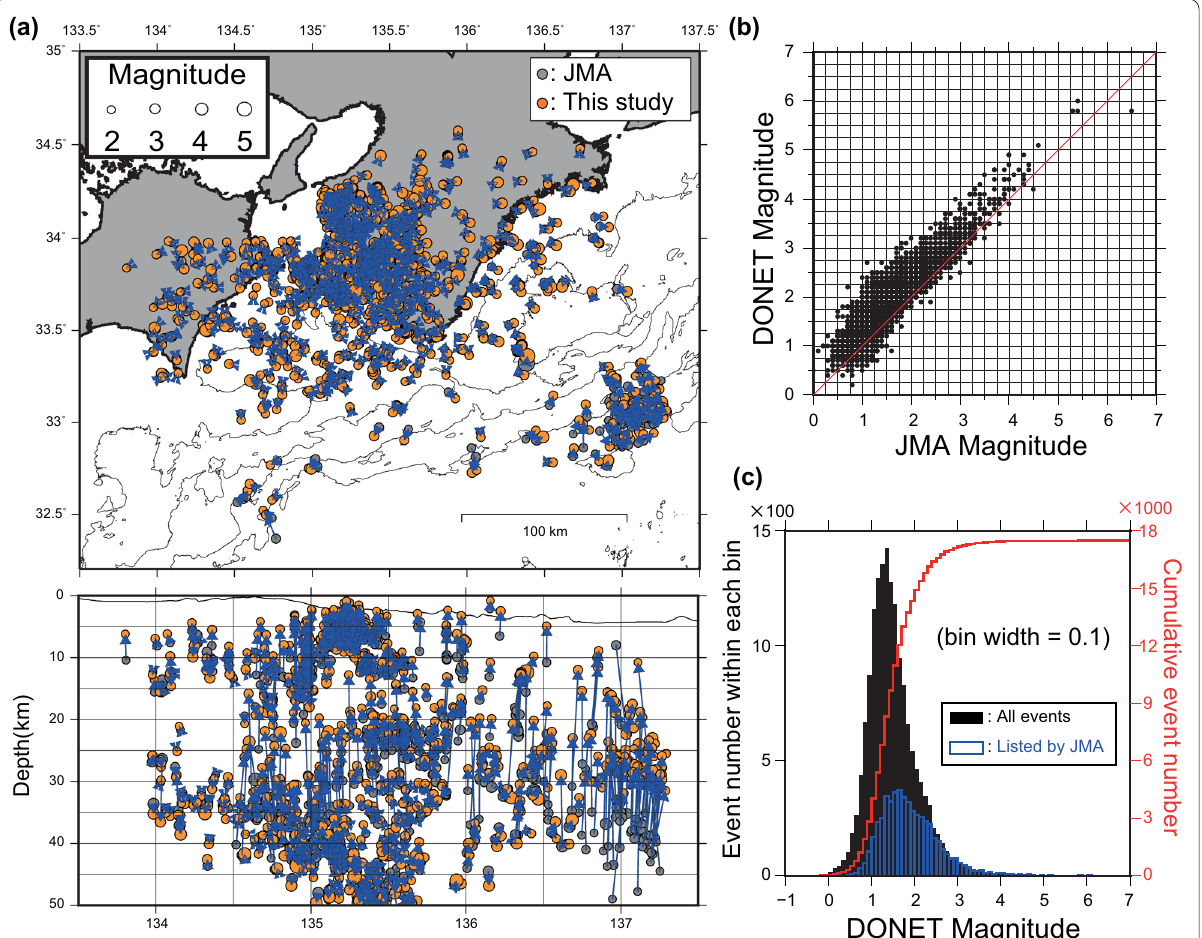
Fig. 6 Comparison of hypocenter parameters between this study and the JMA unified catalog. a Difference in locations. Blue arrows show the vector from the JMA catalog to the relocation result. b Difference in magnitude. c Histogram reflecting the magnitude distribution. Black and blue bars show the number of events included in each bin whose width is 0.1 for all events and the event listed in JMA catalog, respectively. The red line is the cumulative histogram for all events